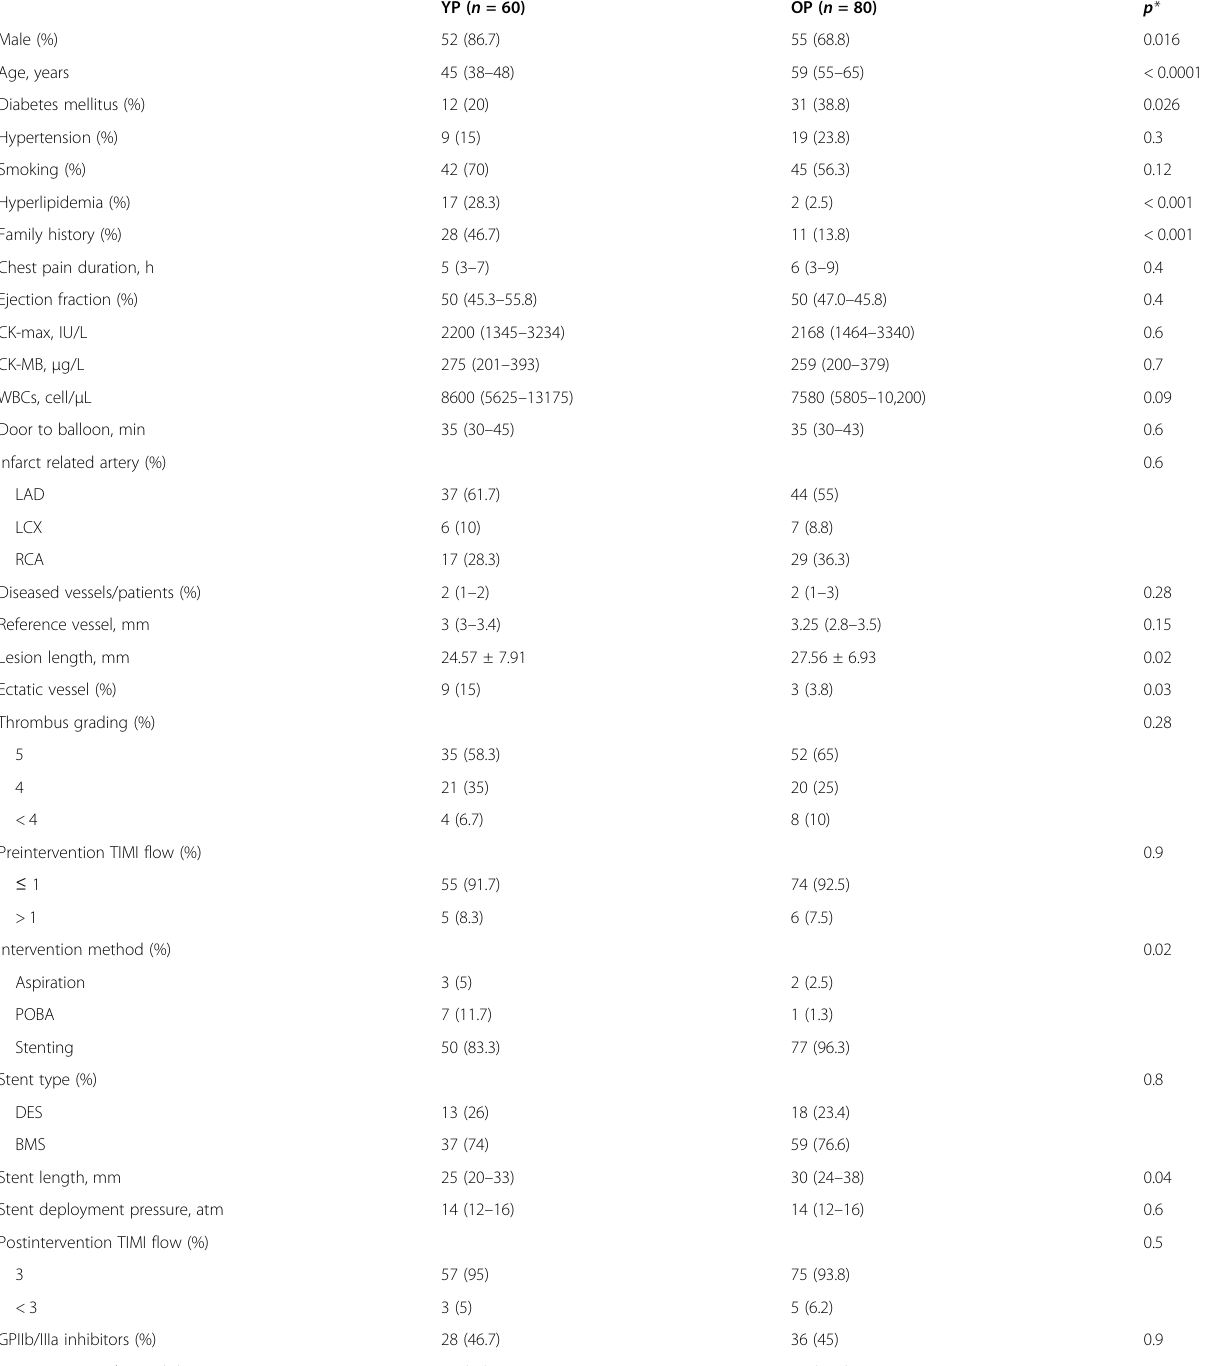
Table 2 Patients ’ clinical and catheterization data in each